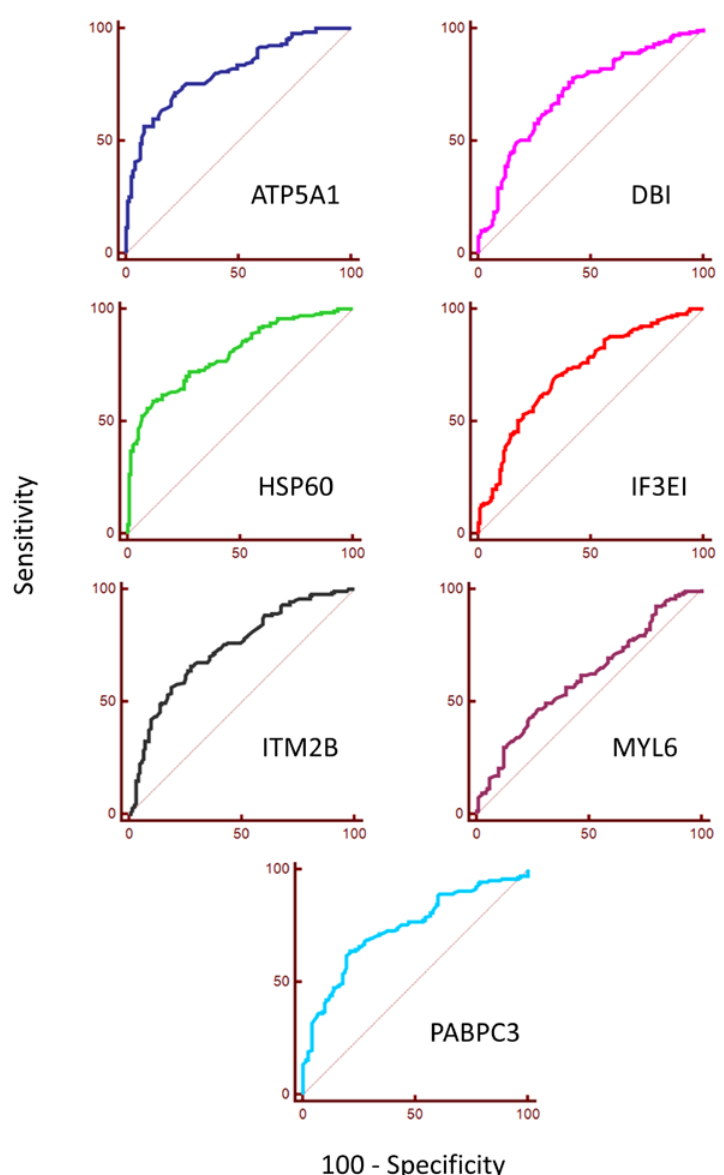
Figure 3. ROC Curves . ROC curves for the seven putative biomarkers (ATP5A1, DBI, HSP60, IF3EI, ITM2B, MYL6, and PABPC3) that were tested in this study were constructed to evaluate the diagnostic accuracy of each protein to differentiate between HR and LR tissue cores. Values for AUC, sensitivity and specificity are given in Table 3. Sensitivity and specificity are listed along with respective cut-off values and likelihood ratios in Supplementary Table S1.